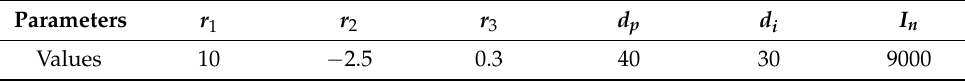
Table 2. Parameter settings of the reward function.